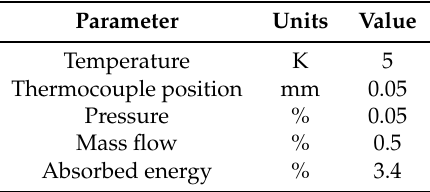
Table 2. Measurement errors.